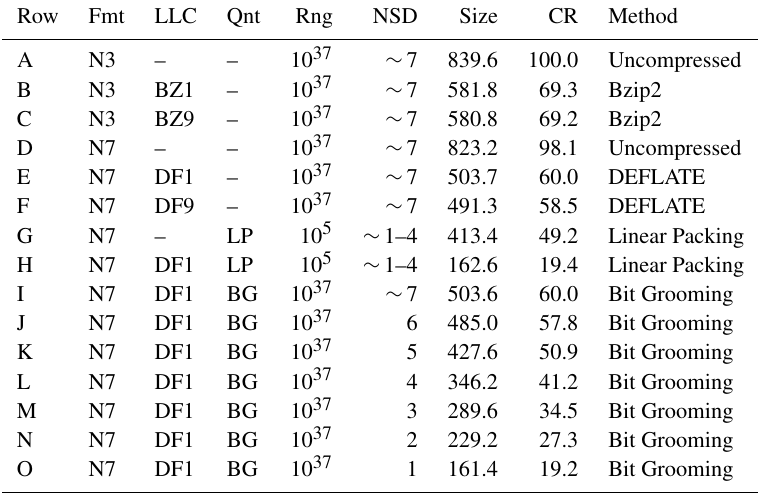
Table 5. Compression ratios for high-resolution initially uncompressed model data ∗